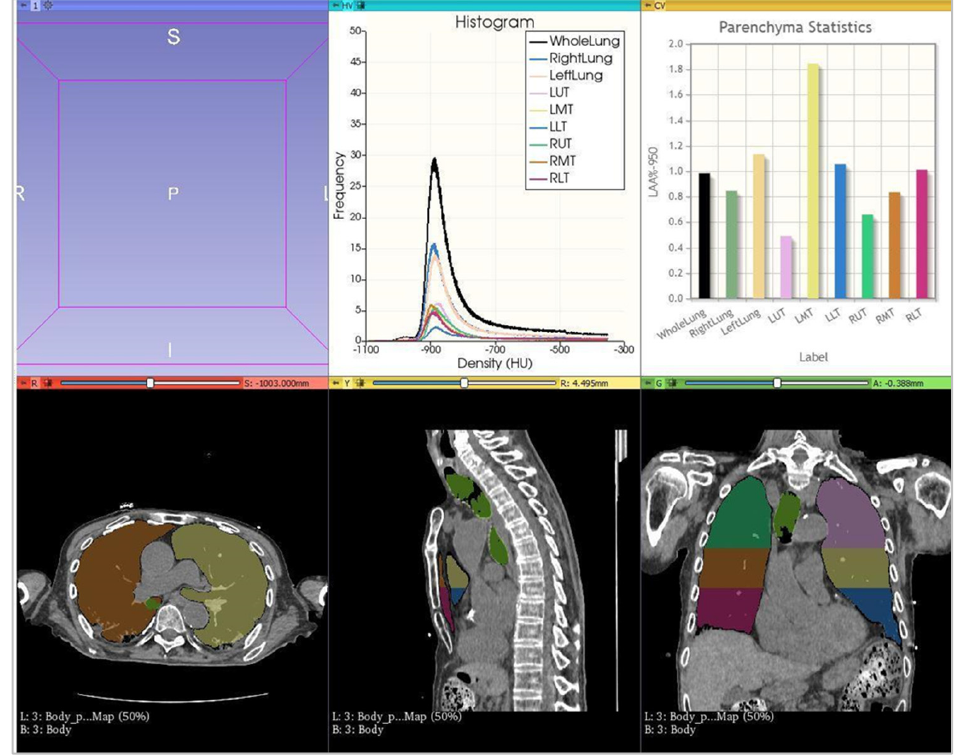
Figure 1. Lung segmentation provided by 3DSlicer. In the first stripe, two graphics concerning the extensions of different densities are shown. In the second stripe, there are three representations of the lung segmentation as provided by the 3DSlicer software, in axial, sagittal, and coronal multiplanar reconstructions.